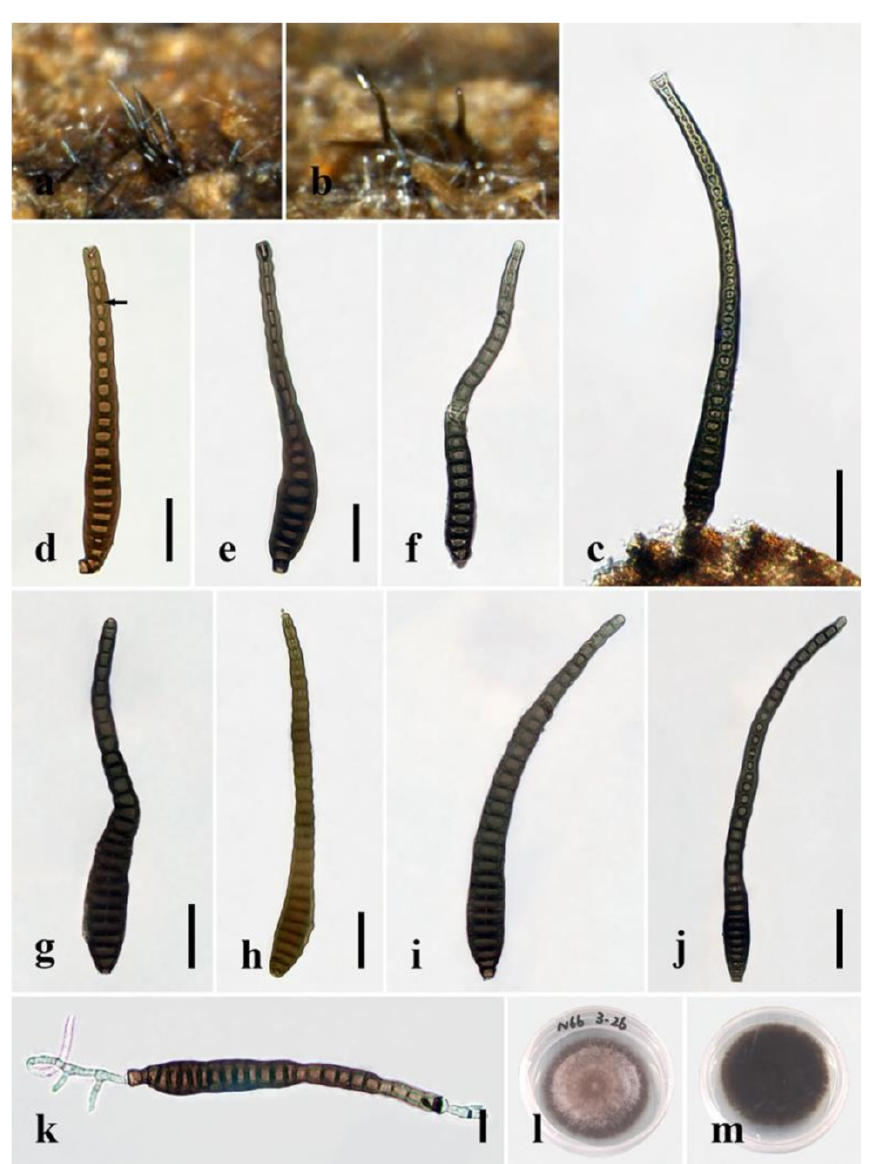
Figure 7. Distoseptispora crassispora (HKAS 122181, holotype). ( a , b ) Colonies on natural substrate. ( c ) Conidiophores with conidium. ( d – j ) Conidia. The arrow in d points to a gap in the middle of the septum, which indicates the distosepta. ( k ) Germinated conidium. ( l ) Colony on PDA (from front). ( m ) Colony on PDA (from reverse). Scale bars: ( c ) 40 µ m; ( d – f ) 20 µ m; ( g – j ) 30 µ m; ( k ) 2 µ m. Index Fungorum number : 559920; Facesoffungi number :